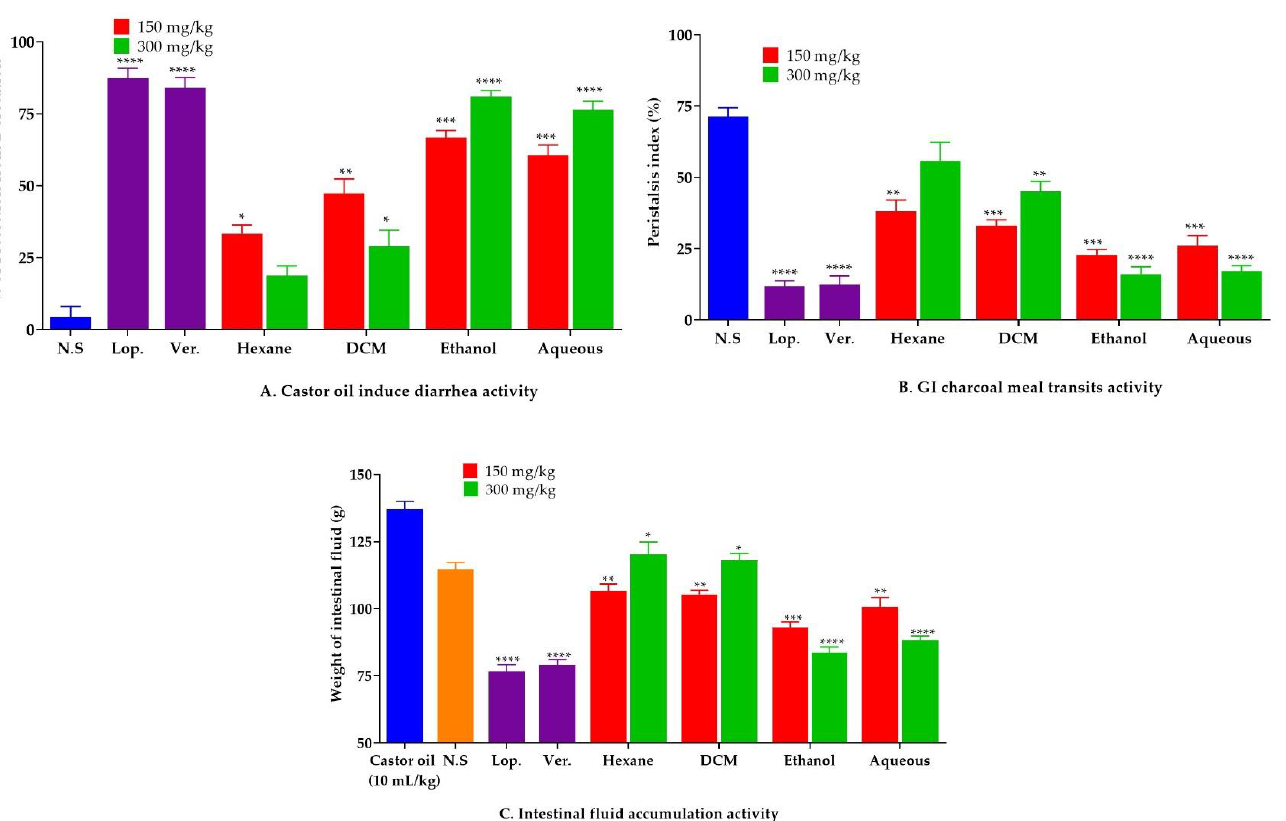
Figure 10. ( A ) Antidiarrheal; ( B ) antiperistalsis; and ( C ) intestinal fluid accumulation activities of C. sativus seed extracts in in vivo studies. The data are presented as the mean ± SD ( n = 5). Data were analyzed using one-way ANOVA followed by Dunnett’s test when compared to the control group (normal saline or castor oil); differences were considered significant at p ≤ 0.05. (* p < 0.05, ** p < 0.01, *** p < 0.001, **** p < 0.0001). N.S.: Normal saline (10 mL/kg); Lop.: Loperamide (10 mg/kg); Ver. Verapamil (10 mg/kg)